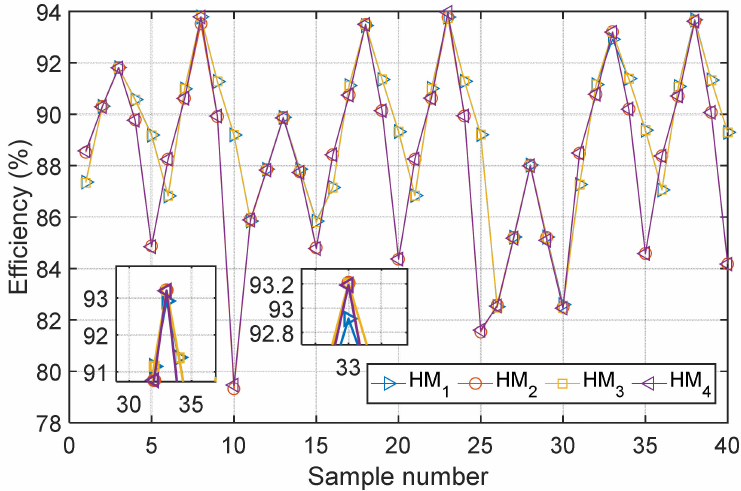
Figure 7. Transmission efficiency of HMCVT stages in the same working